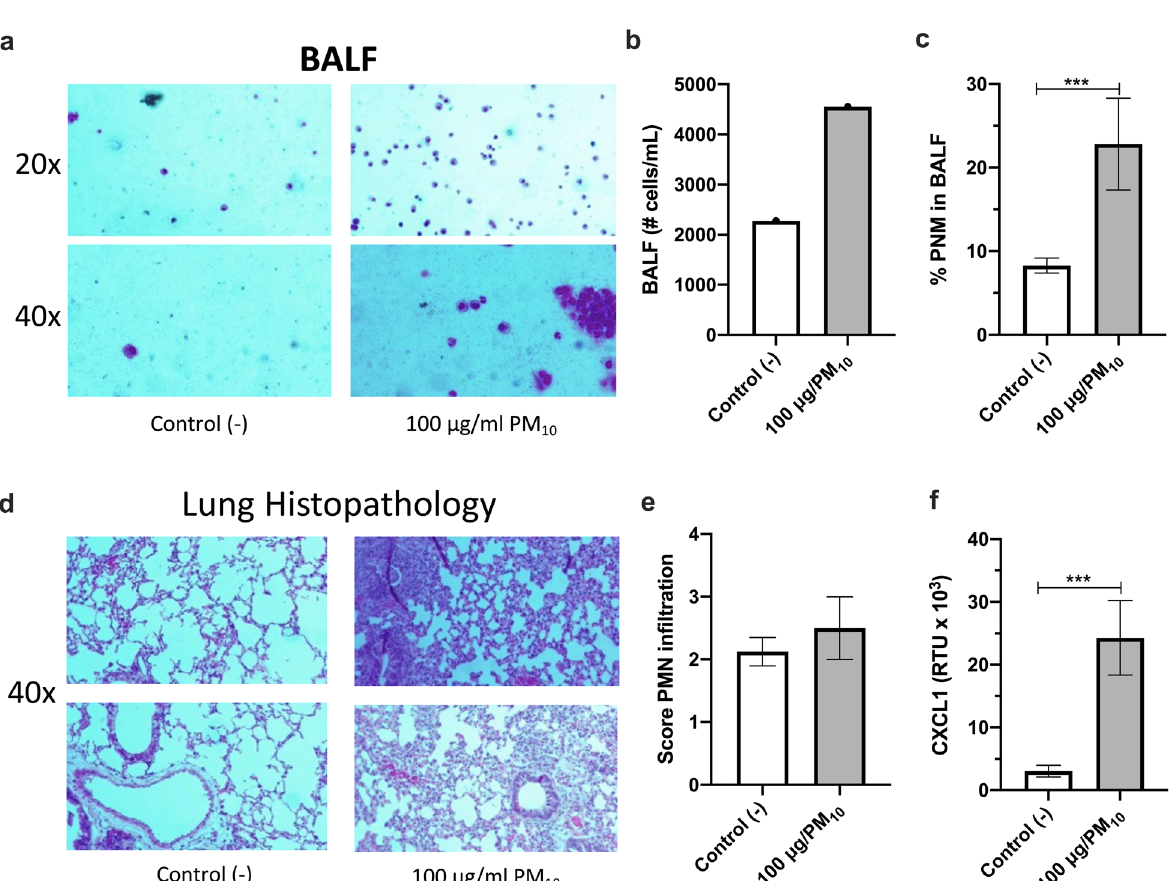
Figure 5. Intranasal treatment with PM 10 increases cellularity and inflammatory infiltrate in the lung. BALB/c mice (n = 9 per group) were treated intranasally with 100 µg PM 10 for five days. On day six post-treatment, the animals were euthanized, and bronchoalveolar lavage and lung tissue samples were collected. Wright’s staining ( a ) quantification of total inflammatory cells ( b ) and quantification of PMNs in BALF ( c ) Representative images ( d ) and an inflammatory score of PMNs infiltrate ( e ) in hematoxylin–eosin stained lung sections, 1 = no infiltrate, 2 = mild infiltrate, 3 = moderate infiltrate, 4 = severe infiltrate. CXCL1 mRNA levels in lung lysate were measured by RT-PCR ( f ). All data are represented as mean ± SEM. ***p < 0.001 by Wilcoxon